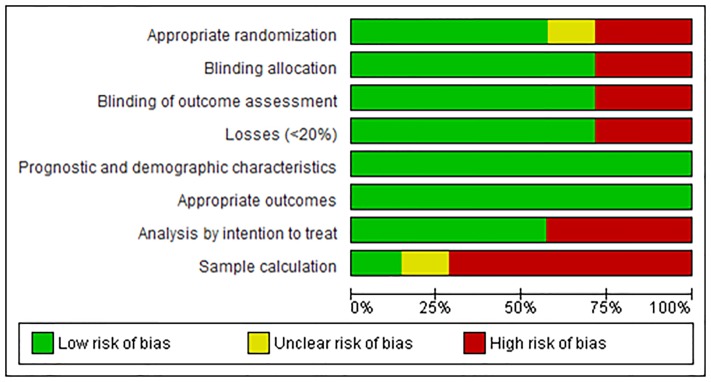
Risk of bias for all studies.